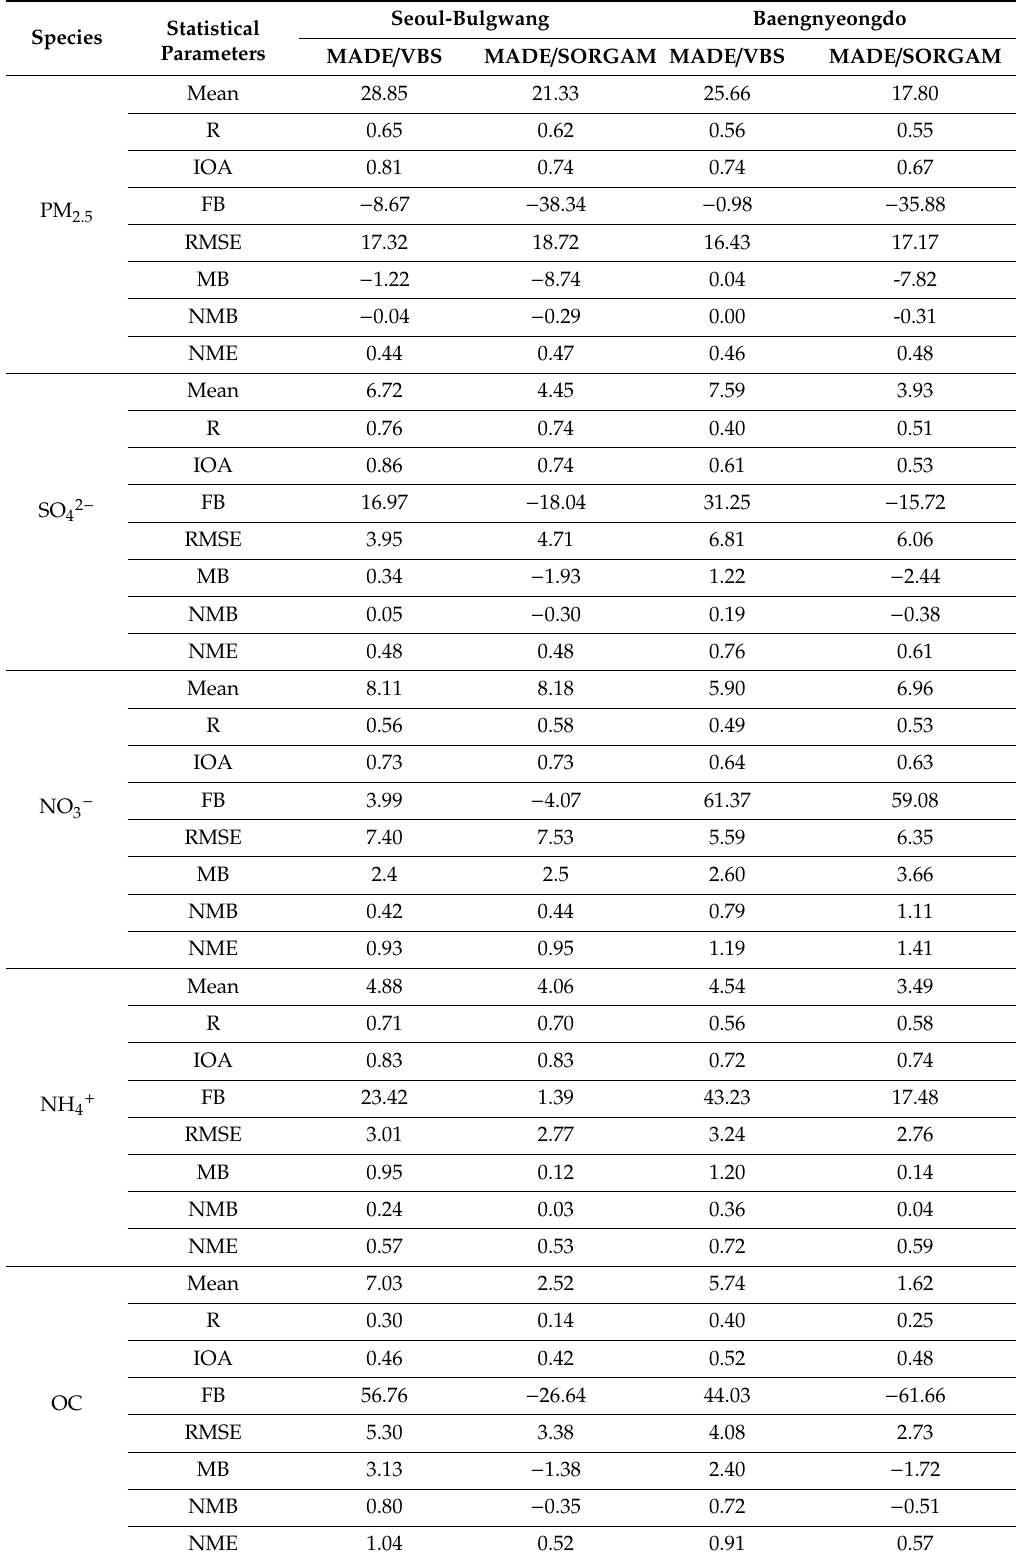
Table 2. Summary statistics for comparison between WRF-Chem simulations and observed PM 2.5 , OC, SO 42 − , NO 3 − , and NH 4 + concentrations at Seoul-Bulgwang and Baengnyeongdo for 1–31 May 2016. Species Statistical Parameters MADE / VBS MADE / SORGAM MADE / VBS MADE / SORGAM